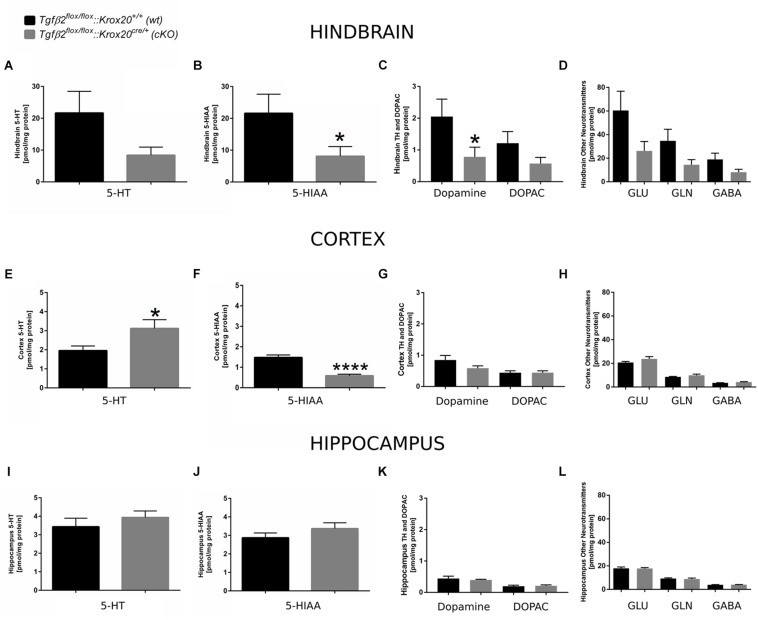
Neurochemical analysis of hindbrain, cortex, and hippocampus of Tgfβ2flox/flox:Krox20+/+ (wt) and Tgfβ2flox/flox:Krox20cre/+(cKO) adult mice. Tissue concentration of 5-HT, 5-HIAA, Dopamine and DOPAC, and glutamate (Glu), Glycine (Gln), and GABA in homogenates of hindbrain (A–D), cortex (E–H), and hippocampus (I–L) of Tgfβ2flox/flox:Krox20+/+ (wt, n = 10–12) and Tgfβ2flox/flox:Krox20cre/+ (cKO, n = 11) adult (3 month old) mice. Data are given as mean ± SEM. ∗p < 0.05, ∗∗∗∗p < 0.0001 using the Mann–Whitney test.